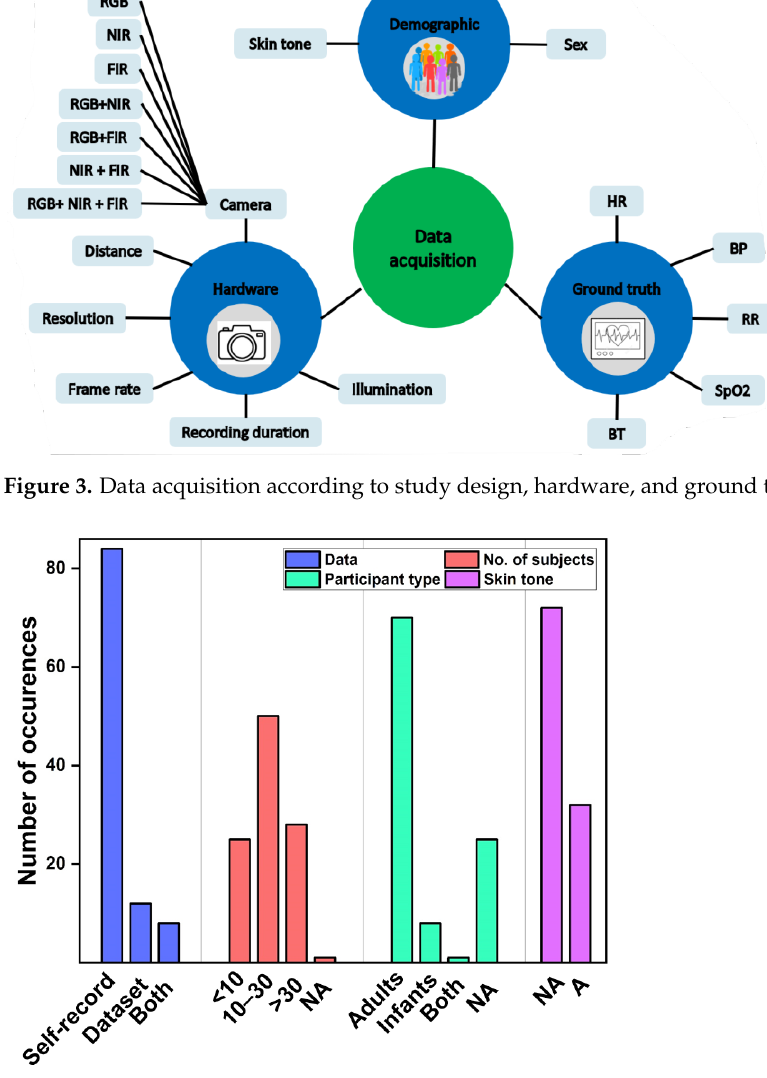
Figure 3. Data acquisition according to study design, hardware, and ground truth.